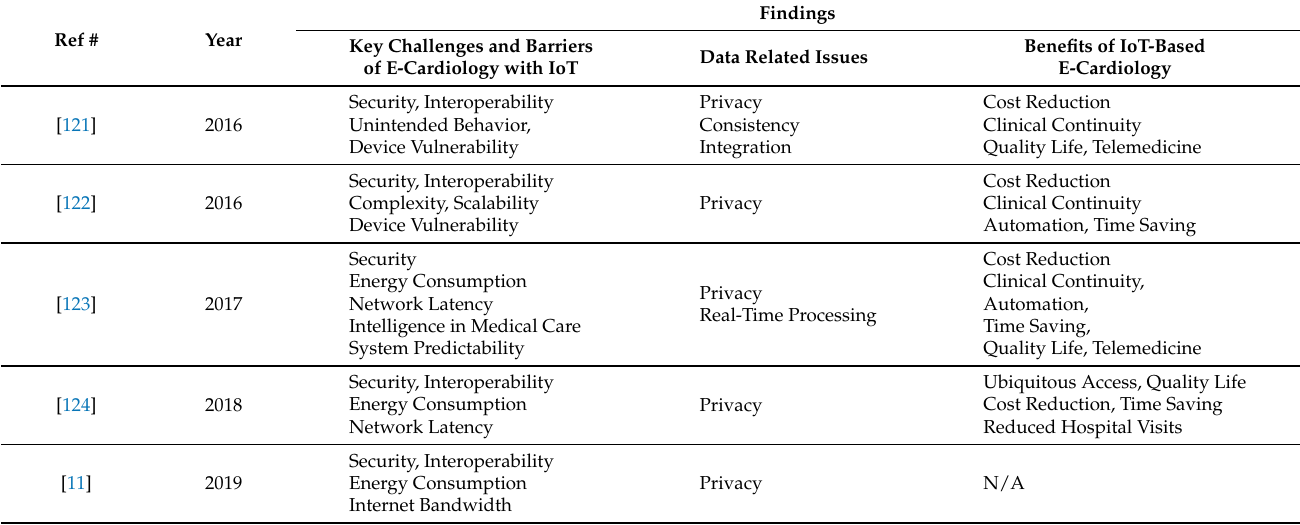
Table 15. Key issues and major benefits of IoT-based